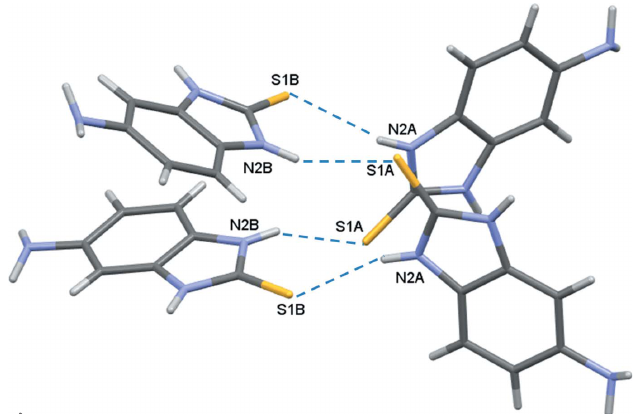
Figure 2 Tetramer of molecules A and B formed by N2 A —H2 NA (cid:2)(cid:2)(cid:2) S1 B and